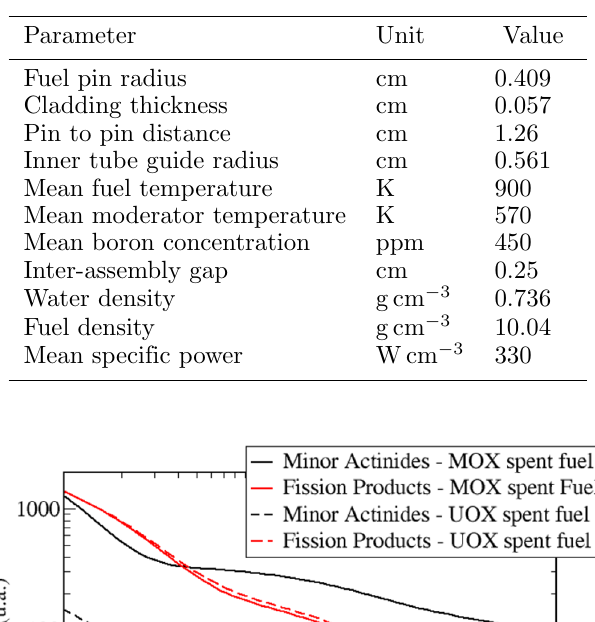
Table 1. Main characteristics of the simulated assembly.